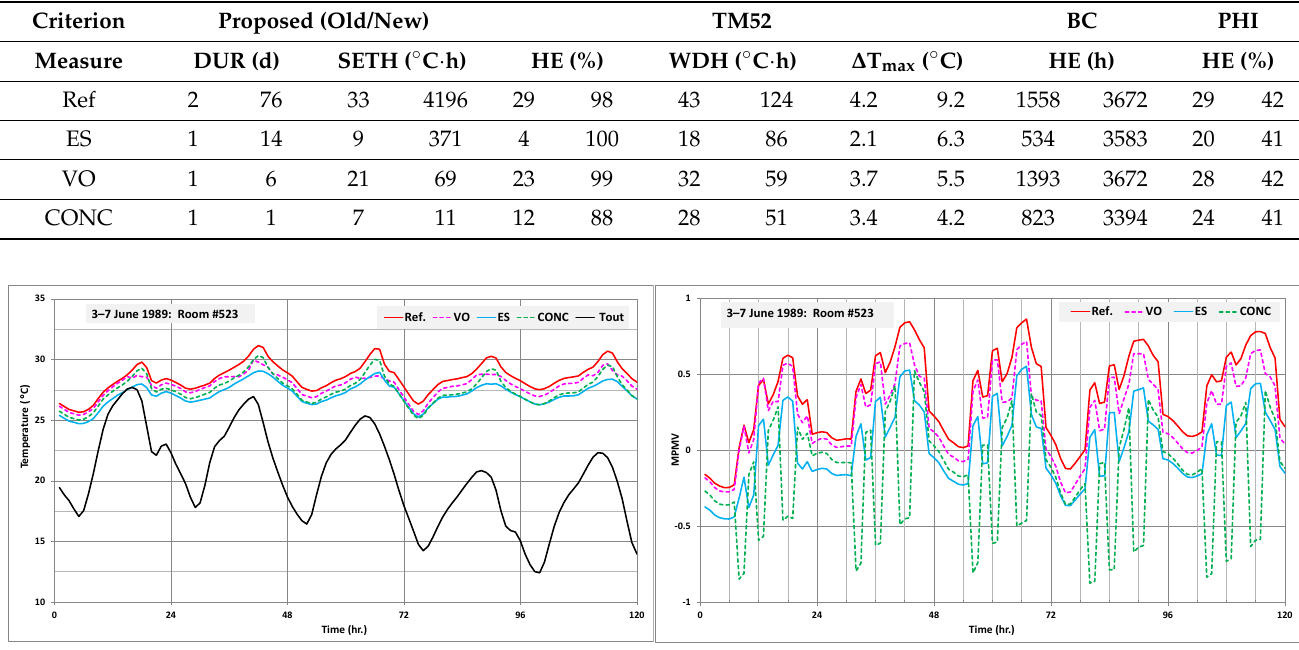
Figure 12. Bedroom temperature and thermal comfort of residents in old LTCH.